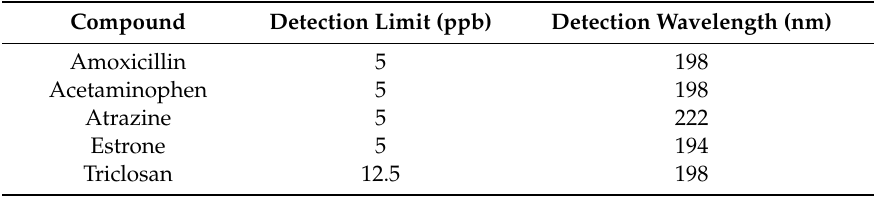
Table 2. The detection limits of five selected